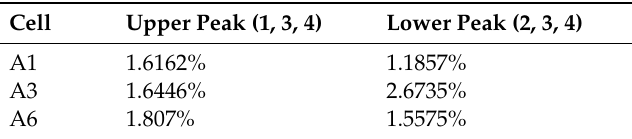
Table 5. Di ff erence in average error estimation while choosing upper and lower peaks to observe the semi-empirical model